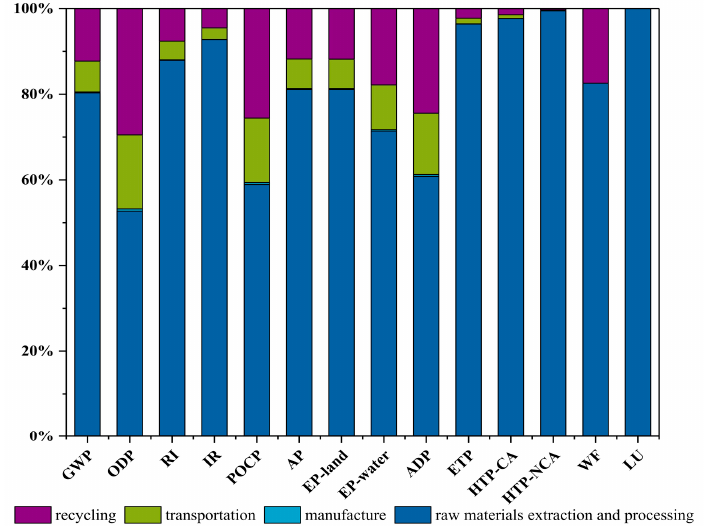
Figure 6. Contribution of the life cycle stages of the lead in LABs packs to each of the impact categories.